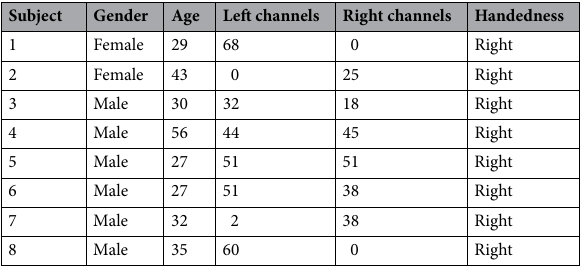
Table 4. Subject demographic. Left channels and right channels denote the number of contacts remaining after the exclusion of bad channels and channels outside of co-registered grey matter